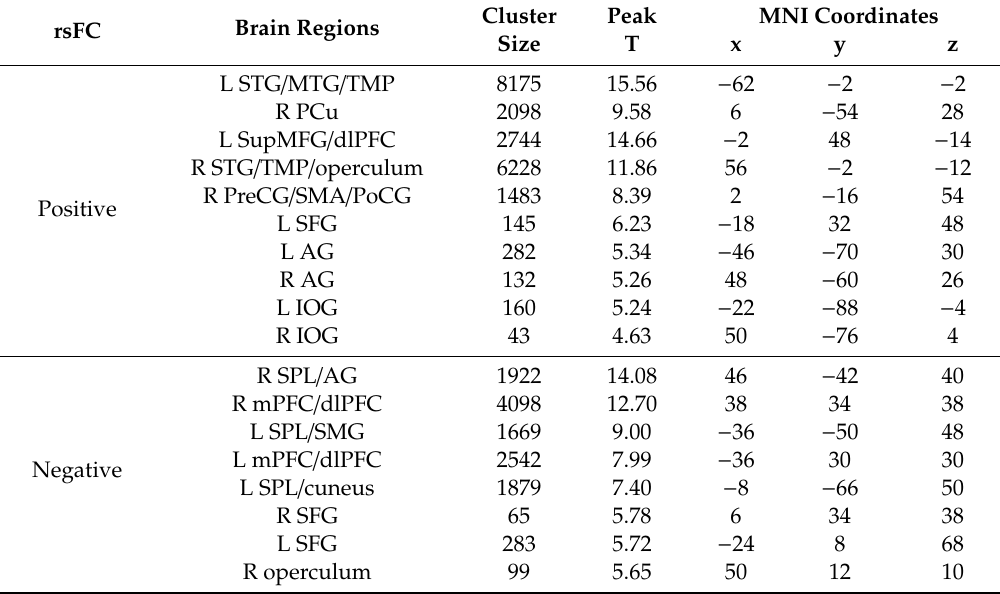
Table 2. Dementia-associated surface regions identified from L hippocampus-based resting-state functional connectivity